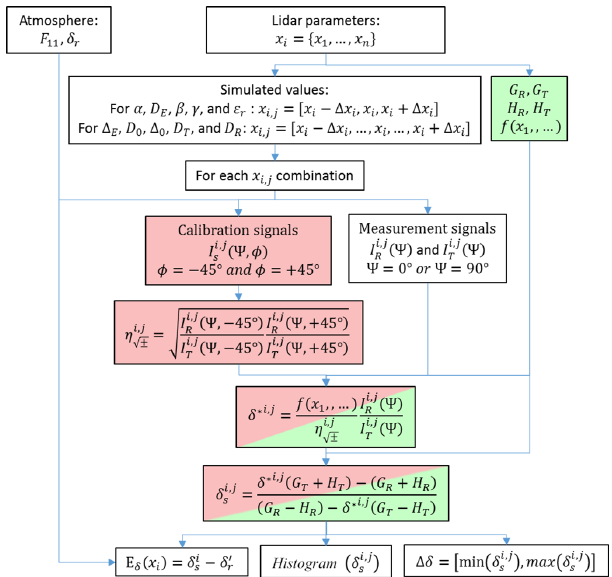
Figure 2. PLS flow chart. The steps of the polarization calibration are marked in red, whereas the correction steps applied with the assumed true parameters are marked in green. x 1 ... x n are the lidar parameters from Table